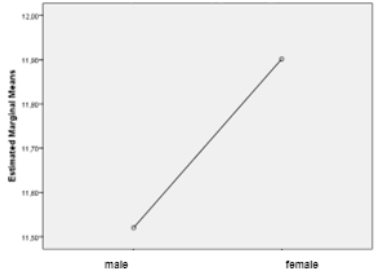
Figure 2. Evaluation of socio-emotional competence in terms of participants’ gender (n =1322) (source: created by